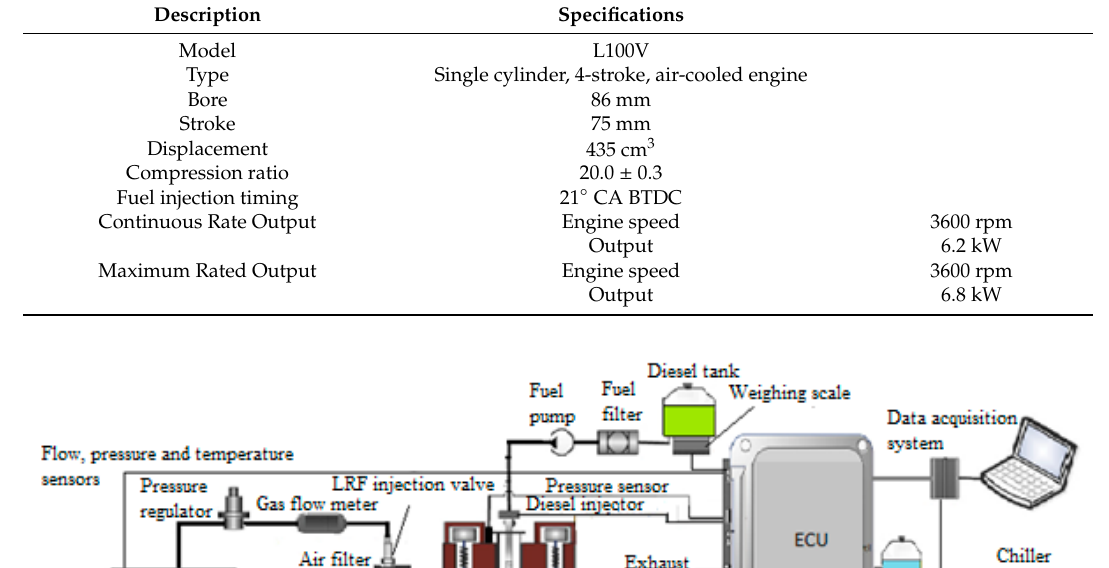
Table 1. The technical specification of the test equipment (engine).